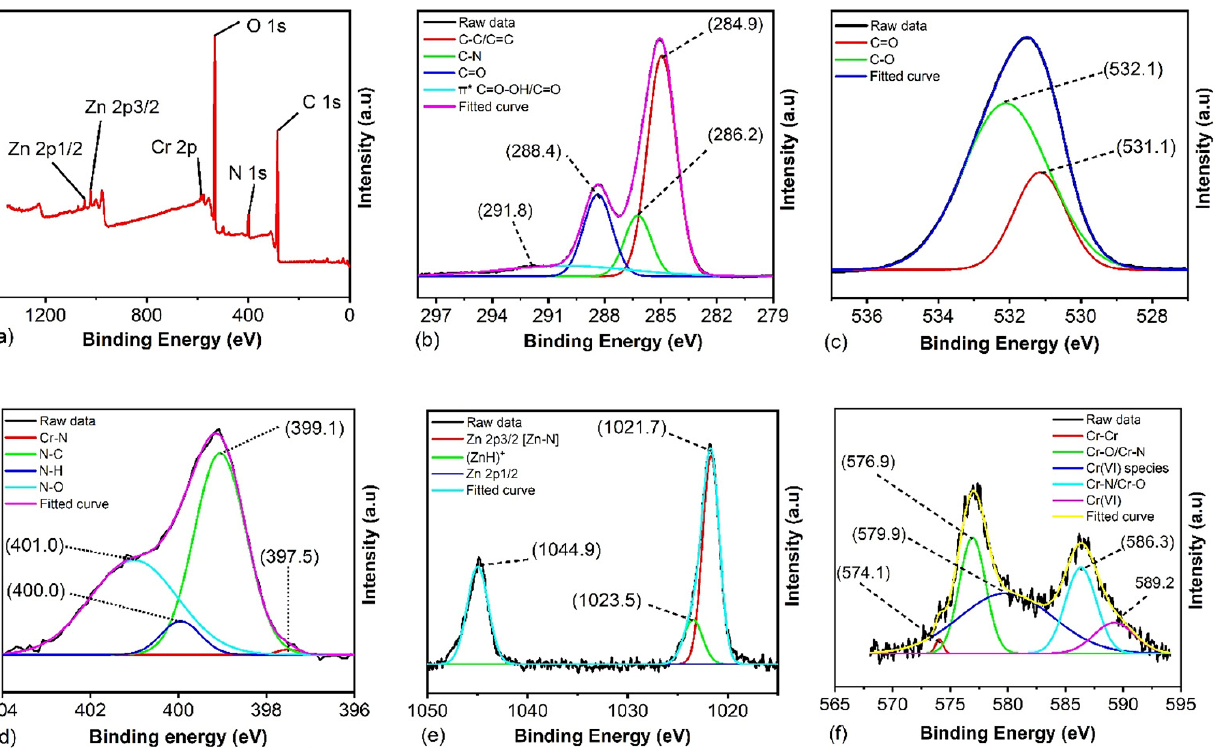
Figure 3. XPS spectra of N,Zn-CDs + Cr(VI) system ( a ) survey spectrum, ( b ) carbon deconvoluted peaks (C 1s), ( c ) oxygen deconvoluted peaks (O 1s), ( d ) nitrogen deconvoluted peaks (N 1s), ( e ) zinc deconvoluted peaks (Zn 2p), and ( f ) chromium deconvoluted peaks. * The mixed Cr(VI) species identified within 579 eV are those of Cr(VI)/CrO 3 , Cr(VI)/CrO 42 − , and Cr(VI)/Cr 2 O 72 − [52].